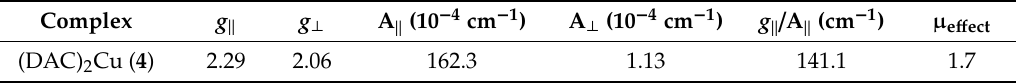
Table 4. Electron paramagnetic resonance (EPR) spectral data of complex (DAC) 2 Cu in DMF. Complex